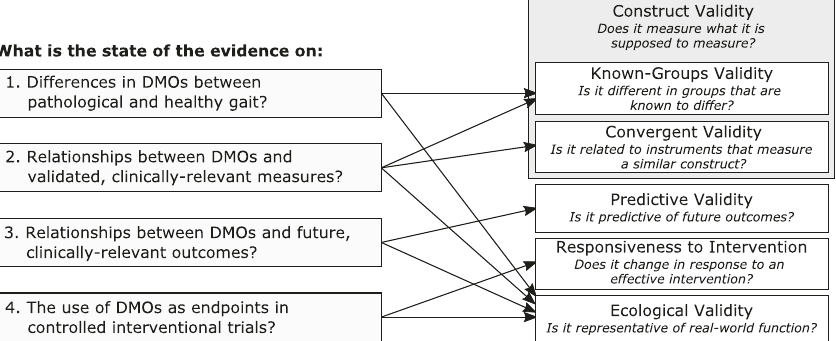
Fig. 1 Research questions (left) and psychometric properties (right) addressed by this review. DMO digital mobility